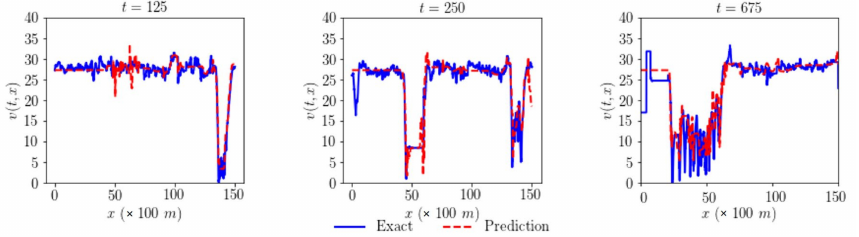
Figure 10. Actual and predicted speed at three different time intervals of Link L3 with adaptive activation function.